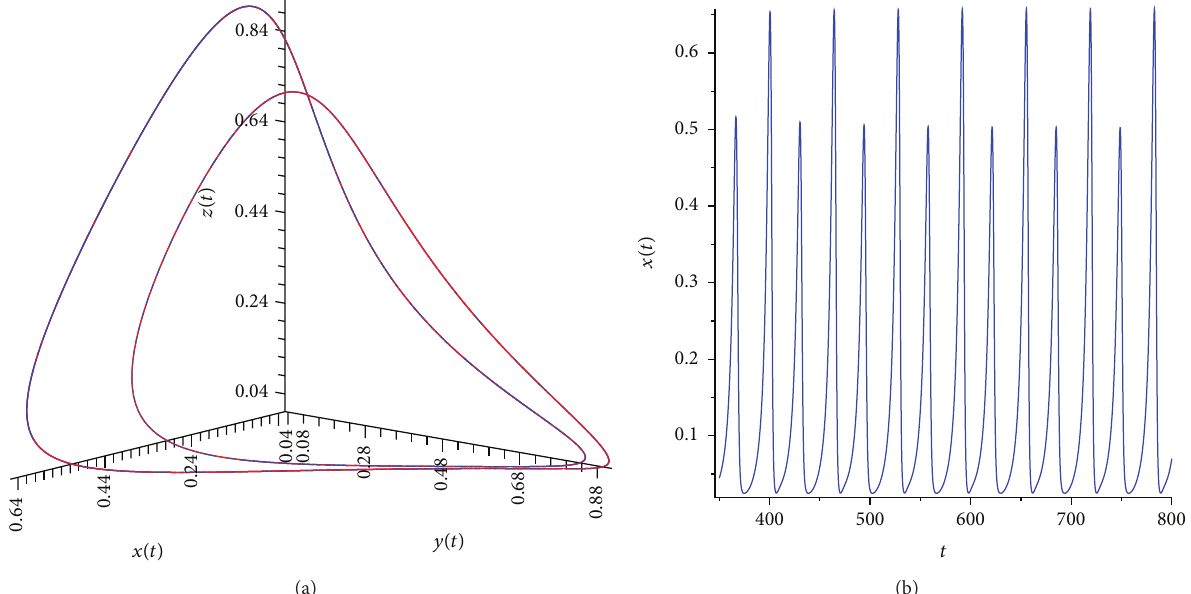
Figure 4: Period-doubling bifurcation occurred with the periodic solution created in the Hopf bifurcation at the equilibrium 𝐺 . (a) Periodic orbit of period 2𝑇 , for 𝑎 = 0.93 . Integration time: [1500, 1600] . Initial conditions: (0.1325, 0.6687, 0.19) , (0.13, 0.6, 0.2) . (b) Periodic behaviour of the coordinate 𝑥(𝑡) of the solution in (a). Integration time: [1500, 1600] . Initial conditions: (0.1325, 0.6687, 0.2)